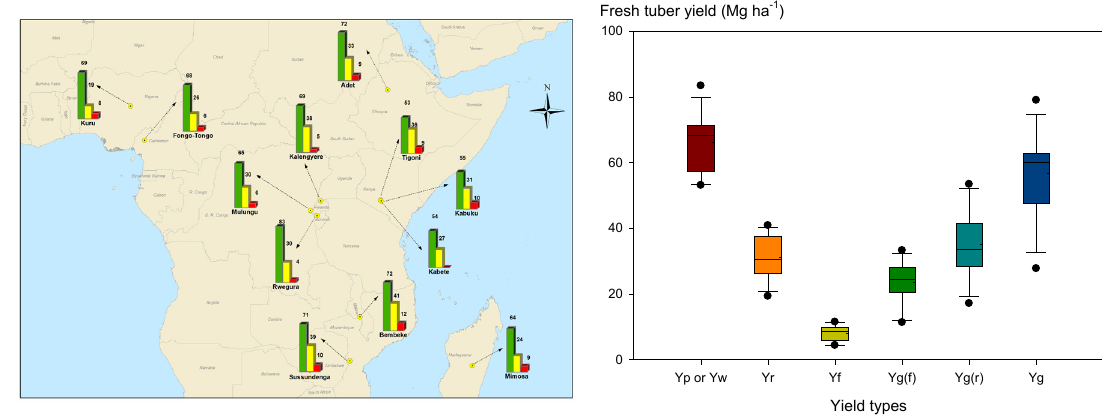
, Y and Y ( left ); box- p r f = potential yield; Y = water-limited potential yield used for Winter potato (Bembeke p w = actual yield obtained by farmers; Y = research yield gap; Y = farmers’ f g(r) g(f) or Y , Y and Y , respectively p w r f